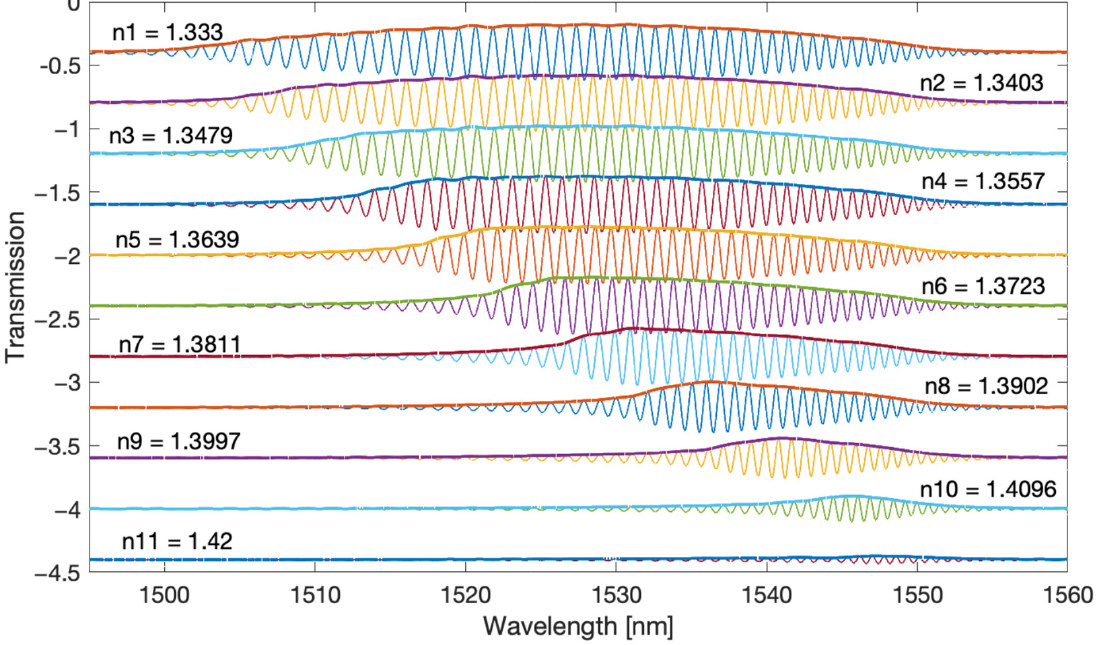
Figure 6. Envelope calculated by the Hilbert transform method for the main frequency band.